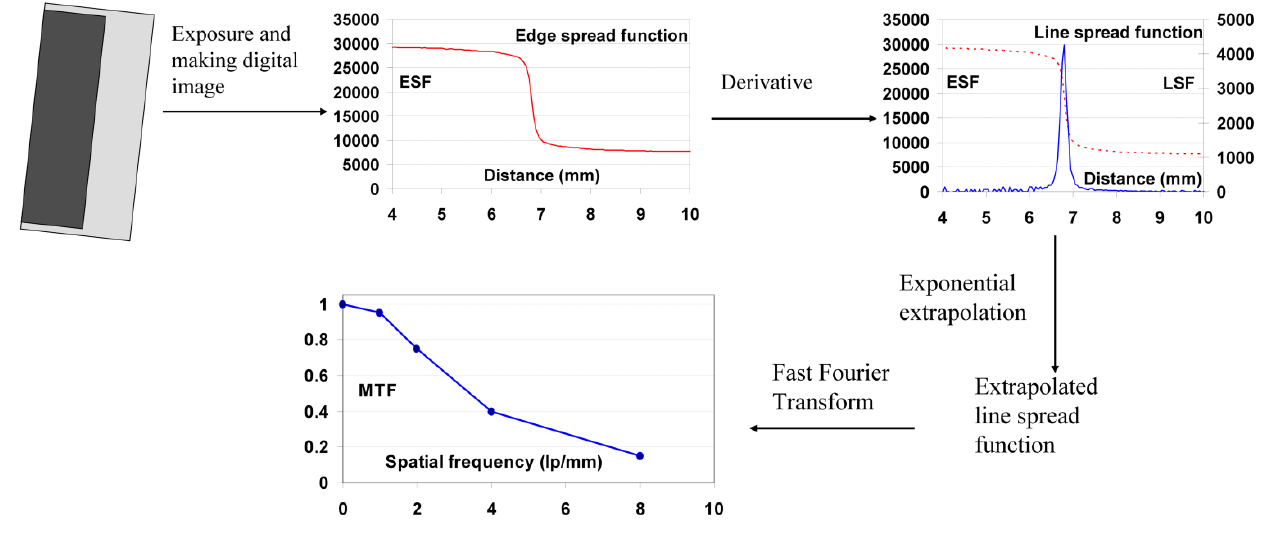
Figure 33. Schematic presentation of MTF measurement with edge